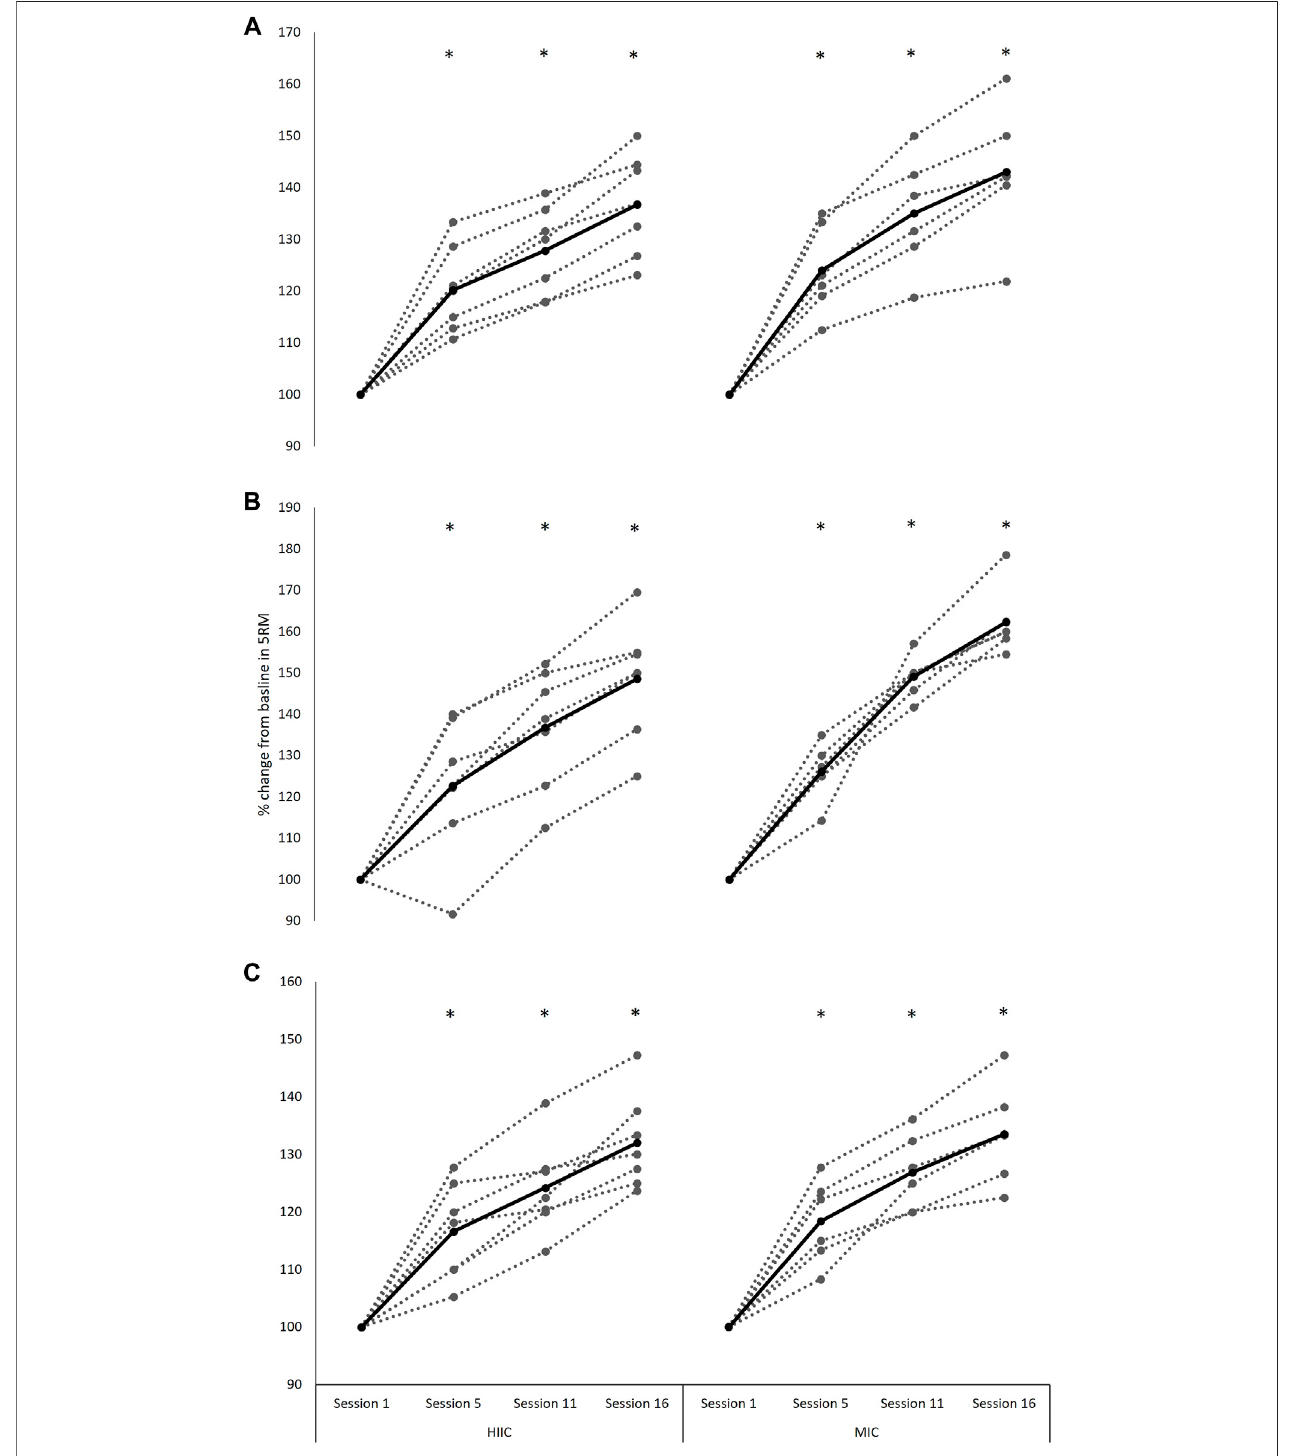
FIGURE 2 | Individual (dashed lines and grey dots) and mean (black lines and black dots) response in phosphorylation of the AMPK signaling pathway in the MICT ( n = 6) and HIIT ( n = 7) groups including representative images. Pre = pre-training intervention, post = post-training intervention, RES = resistance exercise; MICT = moderate intensity cycling; HIIT = high intensity interval cycling.